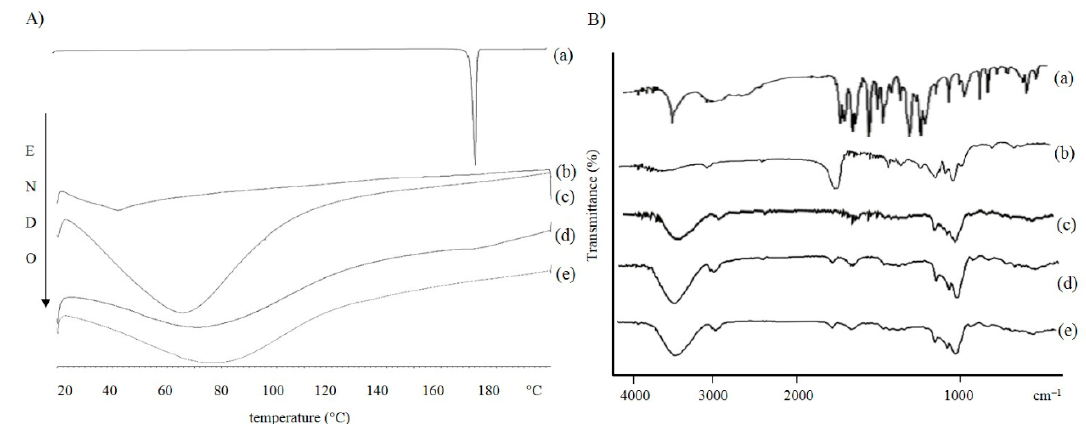
Figure 7. ( A ) DSC and ( B ) FT-IR curves of FA ( a ) PLGA polymer ( b ) HP- β -CD ( c ) unloaded NPB ( d ) and FA-loaded NPB nanoparticles ( e ).